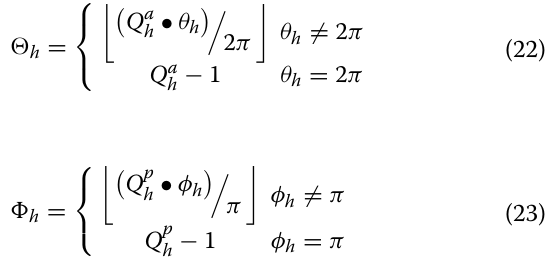
Similar to the presentation in the gradient domain, we use the same method to perform the digitalization of θ h and φ h in the Hessian domain by: